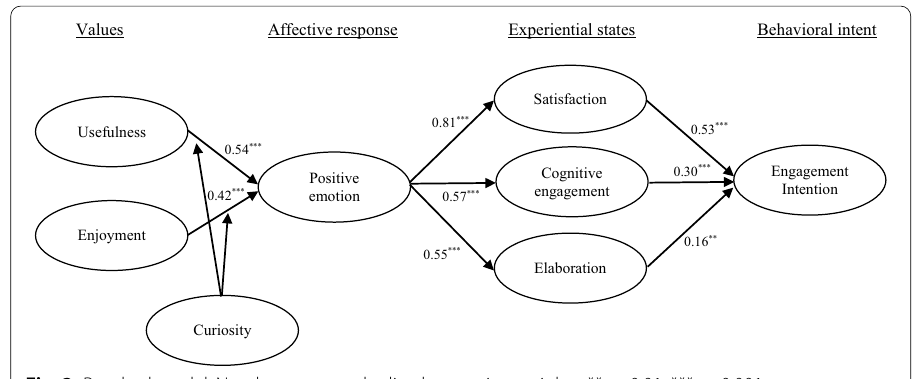
Diagonal entries are AVE for each construct. Off-diagonal entries are the squared correlation coefficients between